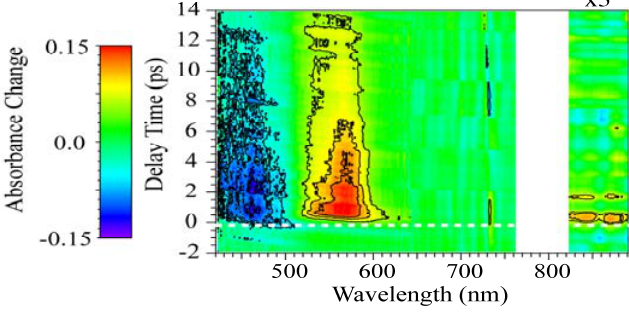
Figure 12. Time-frequency 2D image of the transient absorbance change of β -carotene in PMMA films with an accumulation of 20 laser shots per unit frame. The absorbance change is indicated by contours. The intensity of the image between 820 and 890 nm is magnified by three